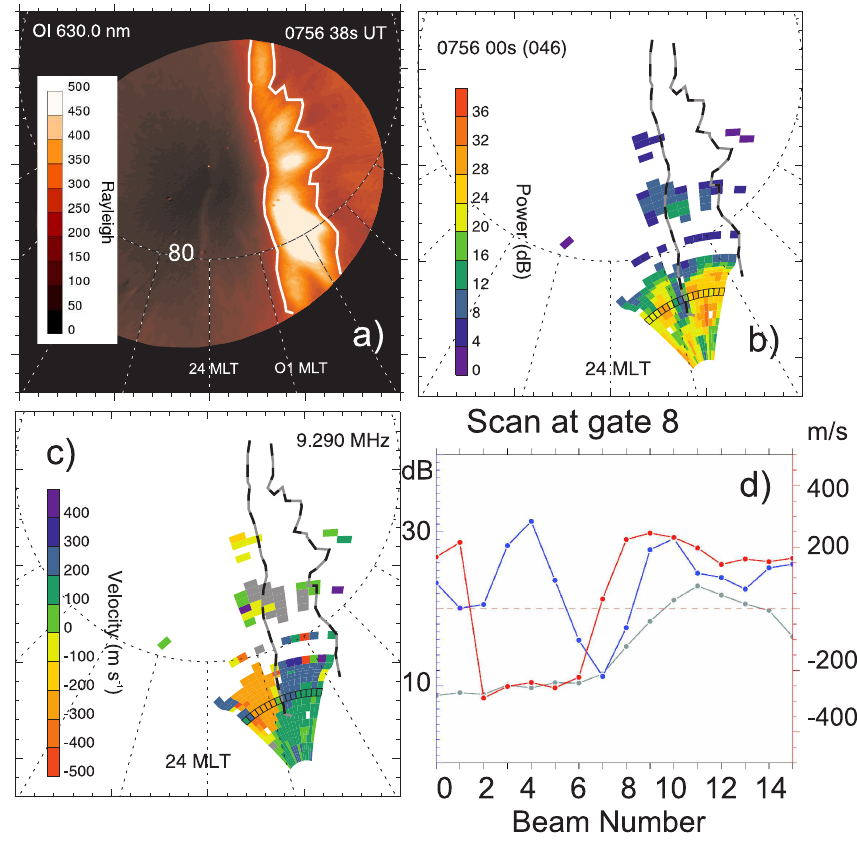
Fig. 4. (a) Auroral luminosity observed by the RES OMTI camera at 07:56:38UT in MLT-MLAT coordinates. The locations of the arc edges are shown by white ragged line. The side closer to the RES location in the center (the duskward side) corresponds to the arc’s upper part); (b) Rankin Inlet radar echo power map and the location of the luminosity edges as presented in panel (a); (c) Rankin Inlet radar echo velocity map (positive: toward the radar) and location of the luminosity edges as presented in panel (a); (d) Luminosity (black), echo power (blue) and velocity (red) variations with the beam number in gate 8 (range of 540km). Location of gate 8 is indicated on panels (b) and (c) by dashed